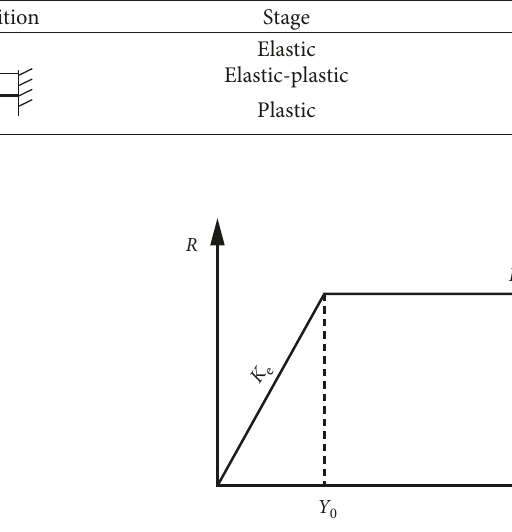
Figure 11: Equivalent single-degree-of-freedom model. (a) Actual structure. (b) Equivalent system. Table 9: Conversion coefficients of the system.